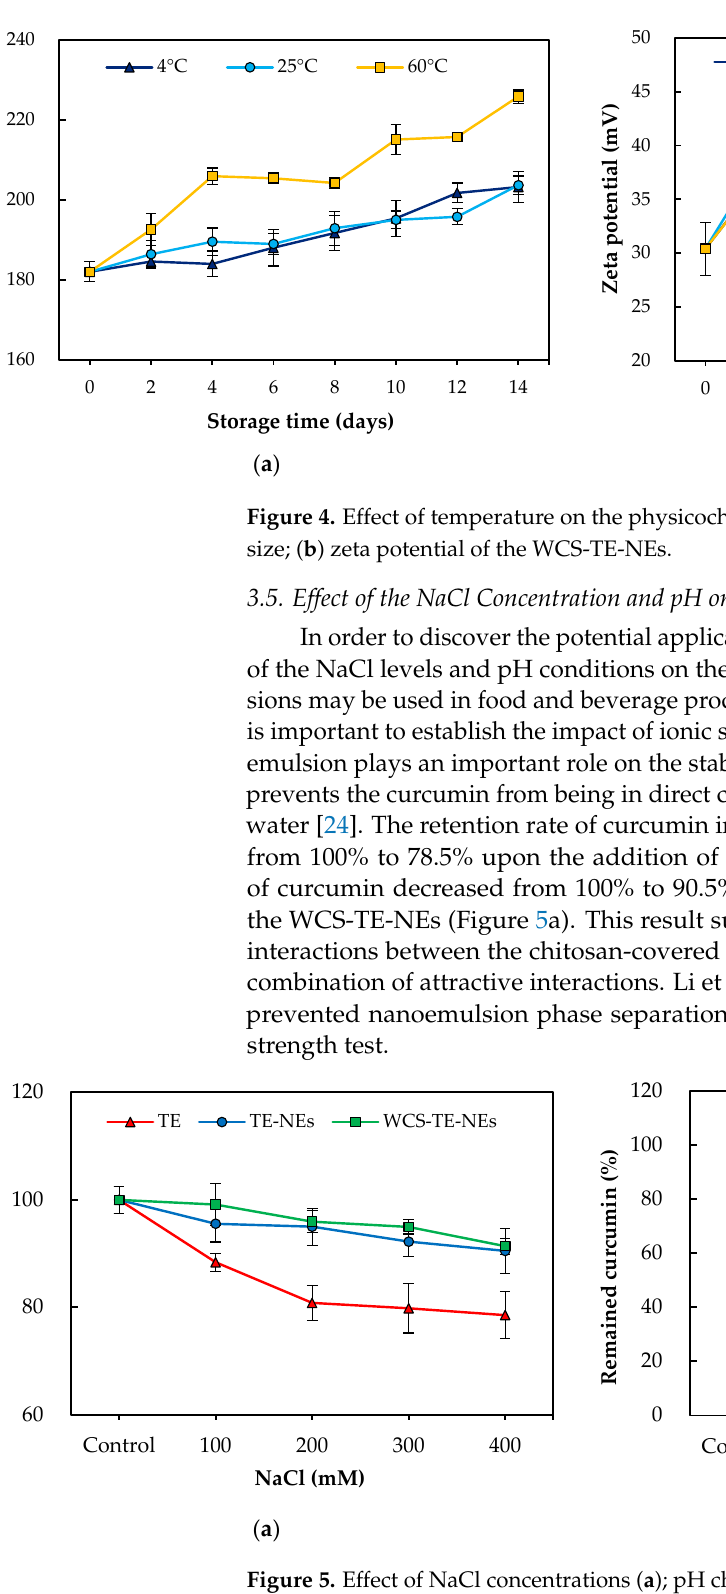
8 of 14 Figure 3. Effect of the TE-NEs/chitosan ratio on the encapsulation efficiency of the WCS-TE-NEs. * Different letters indicate significant differences at p < 0.05 by Duncan’s multiple range test. 3.4. Effect of the Storage Temperature on the Particle Size and Zeta Potential The stability of the WCS-TE-NEs was evaluated by measuring the changes in the par- ticle size and zeta potential over storage time. The WCS-TE-NEs were stored at 4 °C, 25 °C, and 60 °C for up to 14 days, and their particle size and zeta potential were measured by DLS at 0, 2, 4, 6, 8, 10, 12, and 14 days (Figure 4). The particle size of the WCS-TE-NEs were significantly ( p < 0.05) increased at all temperatures during storage. The bigger par- ticle size of the WCS-TE-NEs at 14 days may be mainly ascribed to their swelling over storage time [3]. The particle size of the WCS-TE-NEs were steadily increased at 4 °C and 25 °C for 14 days, but the increase was much lower than that of 60 °C. The PDI of the WCS-